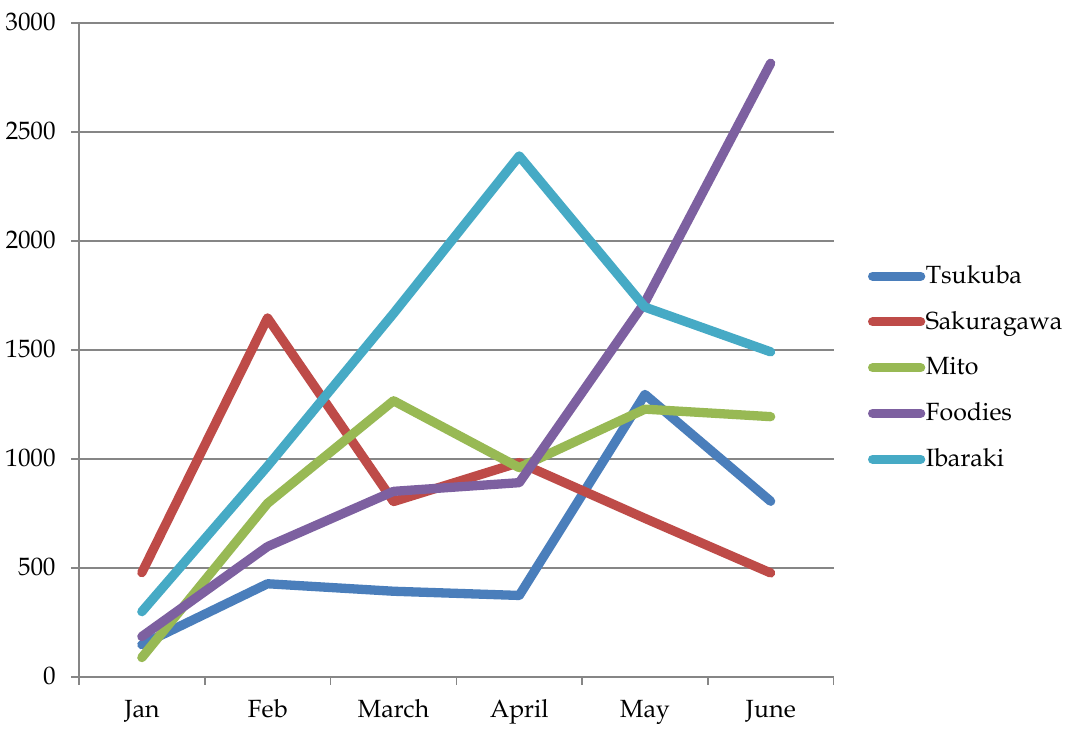
Figure 2: Engagement Features (Total of Likes, Comments, and Shares) on the Top Five Facebook Pages in Ibaraki, January to June